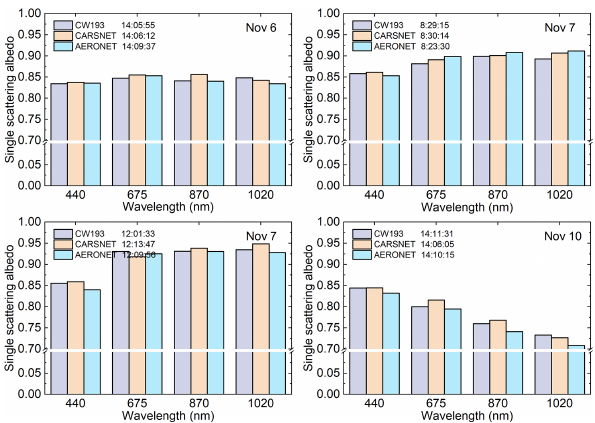
Figure 10. Comparison of the retrieved SSAs from CW193, CARSNET and AERONET for four selected cases.